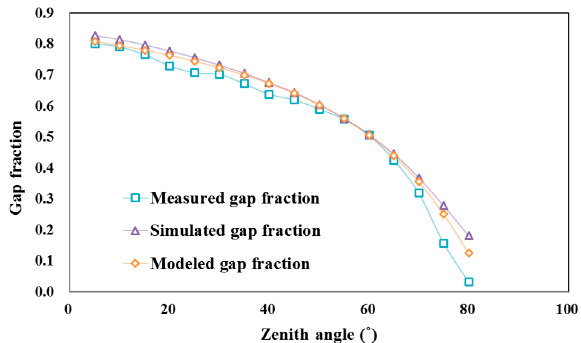
Figure 9. Simulated and measured gap fraction for Larch stands. Parameters are listed in Column 2 in Table 2.